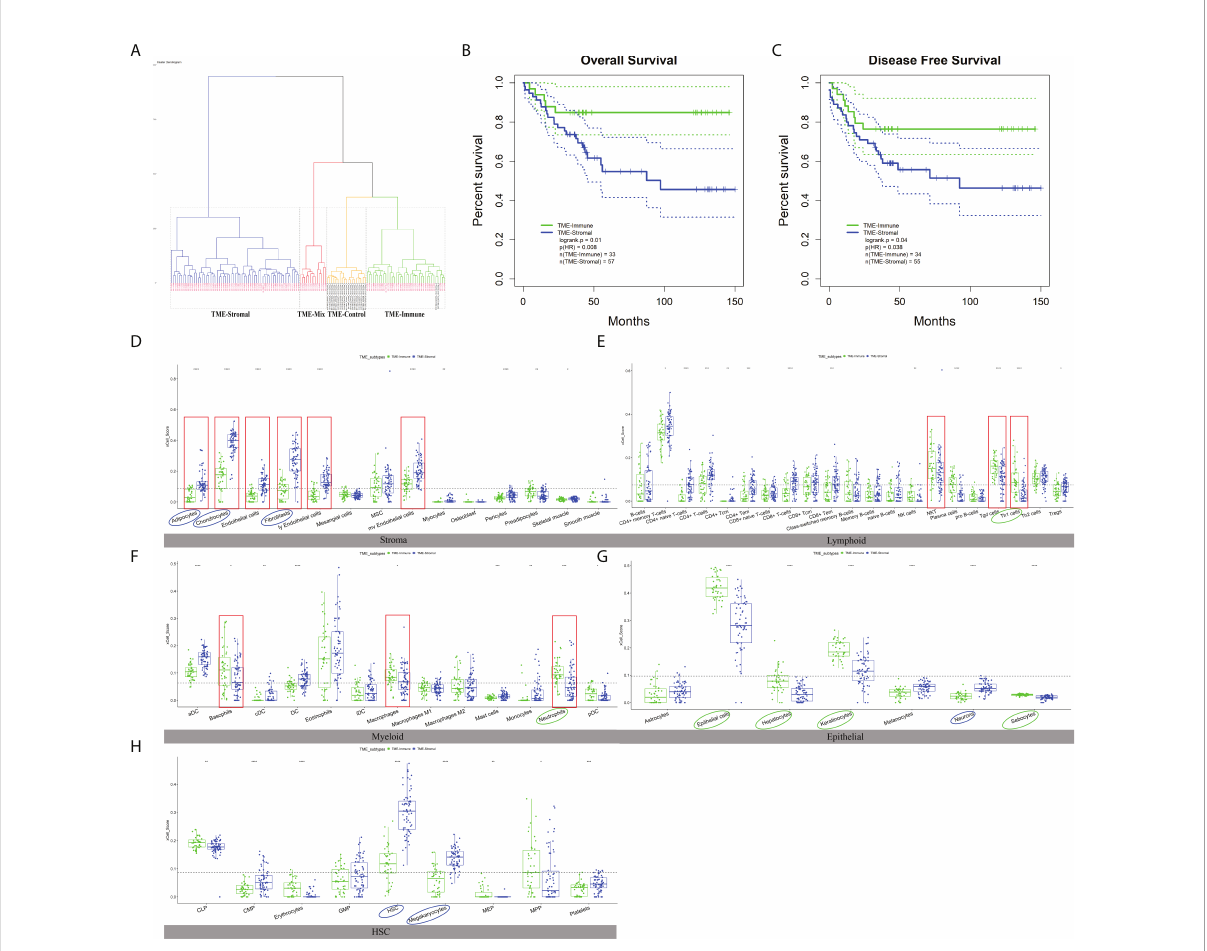
FIGURE 3 The characteristics of TME subtypes. (A) Unsupervised clustering of GSE54129 cohort with matched xCell scores; the samples named in black font was the normal group. (B, C) Kaplan – Meier curves for overall survival (OS) and disease-free survival (DFS) of GC patients with the TME subtypes (log-rank test). (D – H) The distribution of fi ve cell types included 64 TME cells in TME-Stromal and TME-Immune subtypes. TME- Stromal and TME-Immune were shown in blue and green, respectively. The cell types associated with poor clinical outcomes were circled in blue, while the cell types associated with good clinical outcomes were circled in green. The dominant cell types displayed a signi fi cant difference proportion in TME-Stromal and TME-Immune noted by the red rectangular frame. The thick line represented the median value. The bottom and top of the boxes were the 25th and 75th percentiles (interquartile range). The dotted line showed the average score of each cell type. The cells enclosed by the circle were signi fi cant for OS. The statistical difference was compared through the t-test. * p < 0.05; ** p < 0.01; *** p < 0.001; **** p <